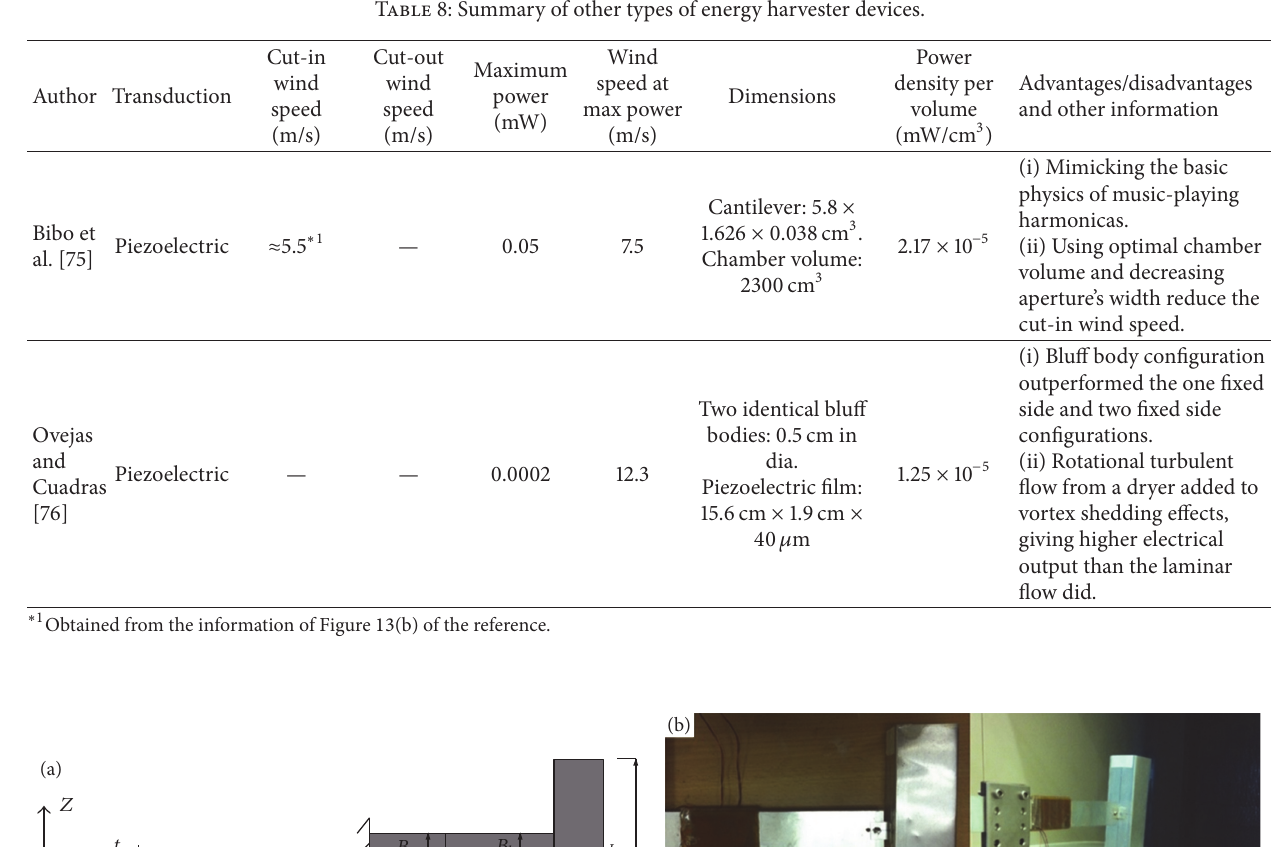
that the square section generates the largest power and has the lowest cut-in wind speed among all the considered